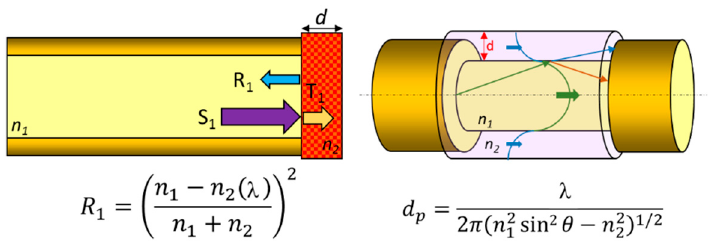
Figure 4. Scheme of the optical absorption phenomenon for a reflection sensor (on the left ) and a transmission one (on the right ); below each one, the Fresnel equation for the reflected power and the expression for the penetration depth of the evanescent field.